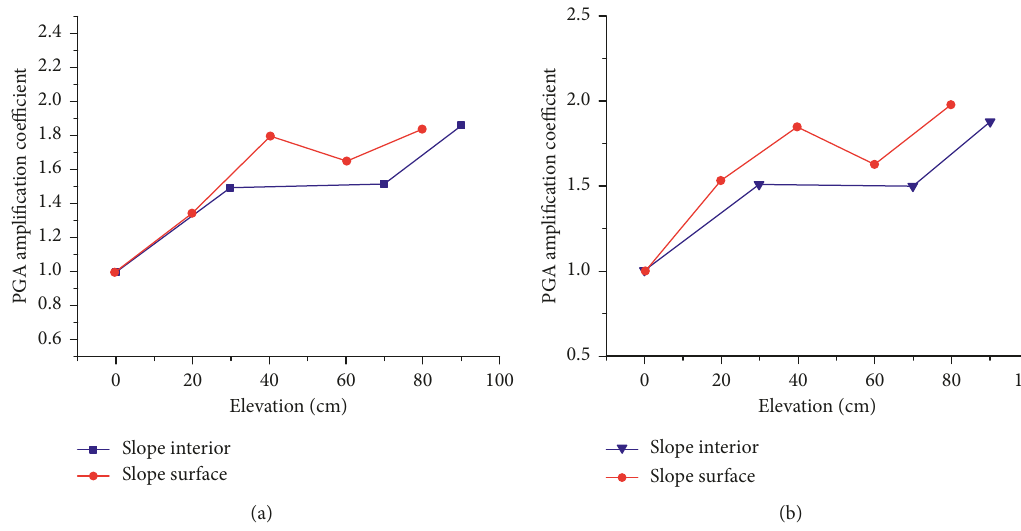
Figure 13: PGA amplification coefficients under condition ELC-1. (a) Convex slope. (b) Concave slope.